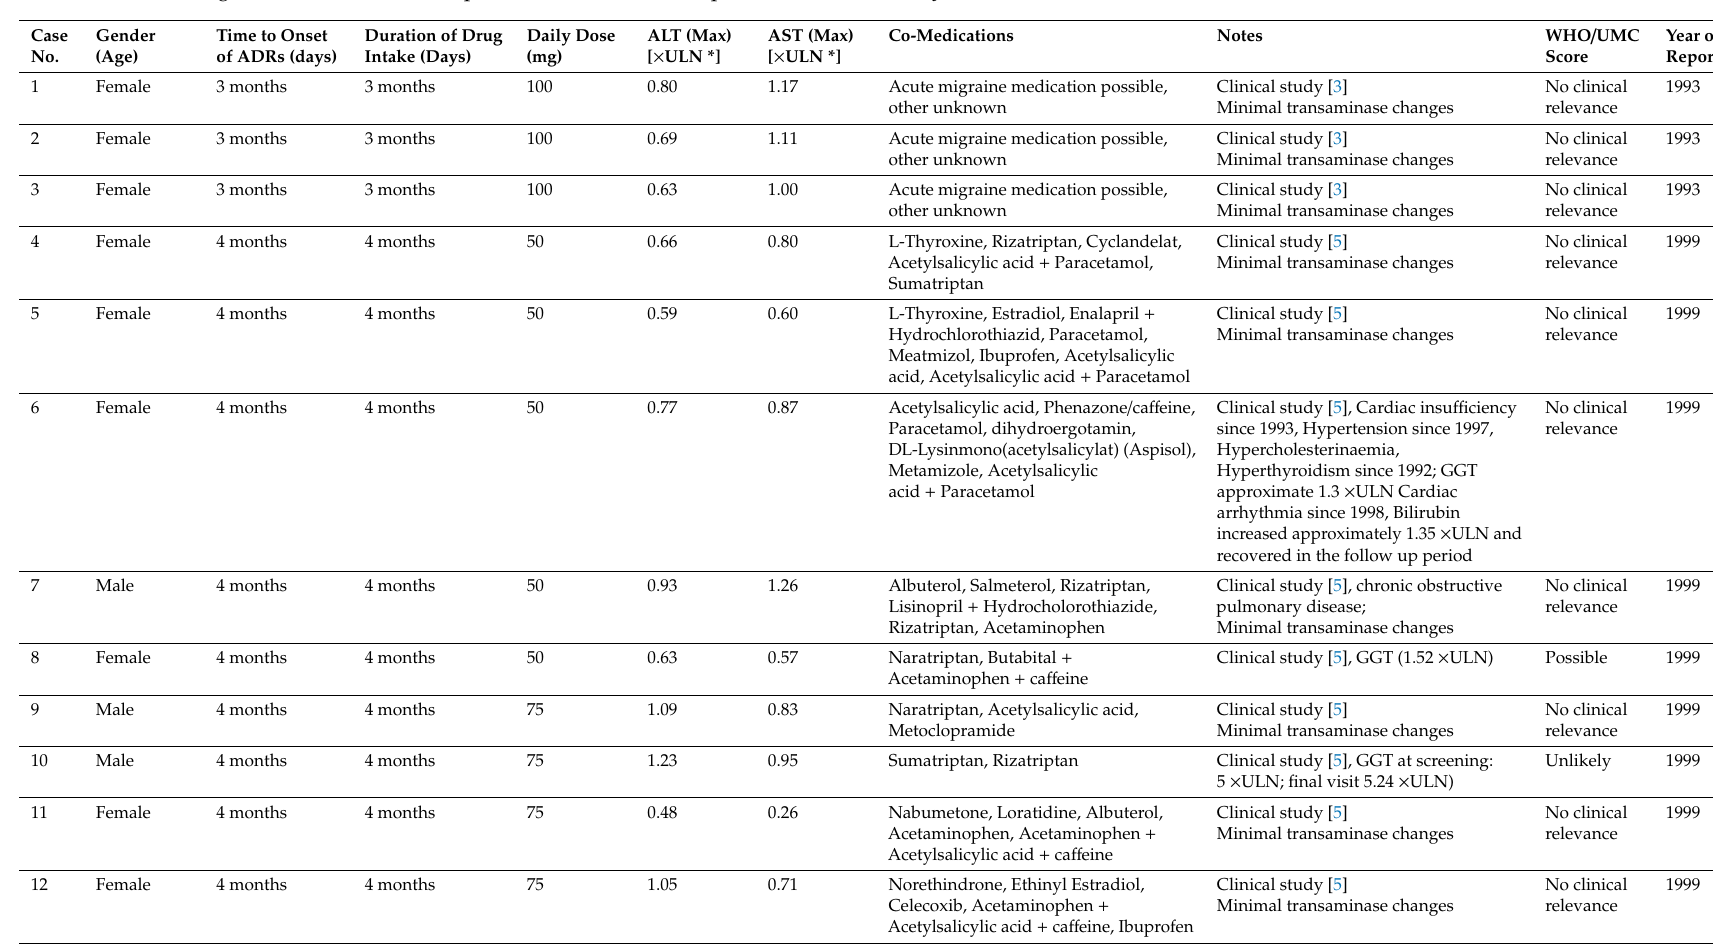
Table 2. Twelve non-serious hepatobiliary ADR case reports recorded during clinical trials with 397 patients on Petadolex ® . Information on 12 hepatobiliary events recorded during clinical studies and suspected to be related to exposure with Petasites hybridus